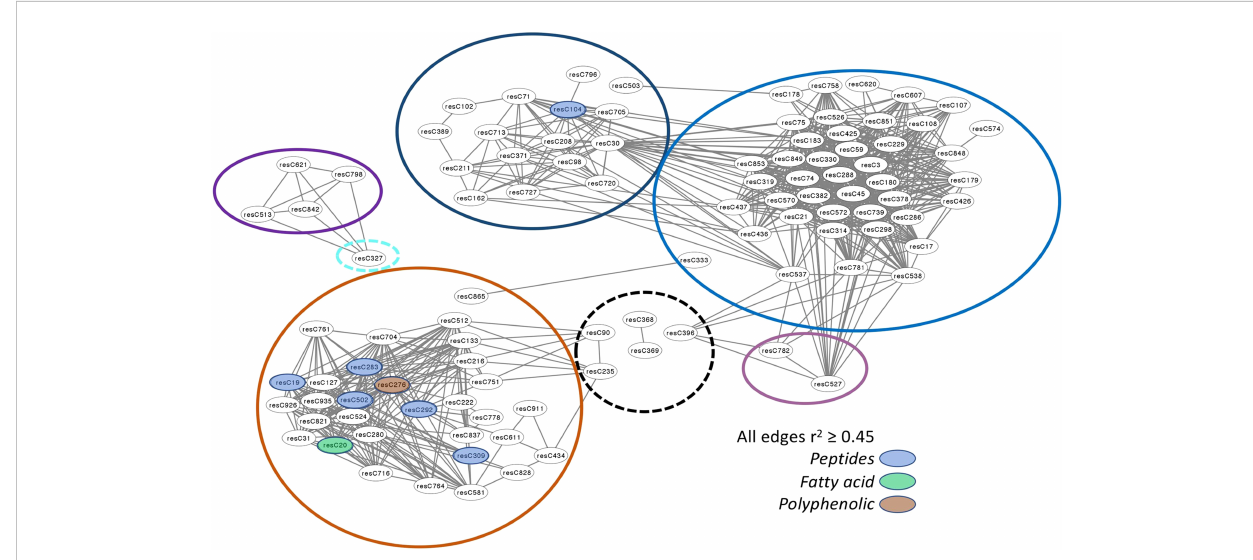
FIGURE 3 Node and edge plot representing the network relationships among features signi fi cantly associated with SNP c2_20259 when evaluated with an additive genetic model. A threshold of r 2 ≥ 0.45 was imposed to simplify the number of edges displayed; 101 nodes are correlated with each other under this rule. These nodes are members of seven modules, de fi ned by the variously colored circles. The fi ve modules whose eigenvalues are signi fi cantly associated with SNP c2_20259 by GWAS are encircled with solid lines; those not associated have dashed lines. Structural information is available for 12 nodes, with their designation as peptides, fatty acids, and polyphenols